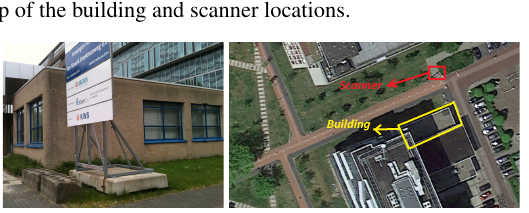
Figure 1: Left; the building chosen for our first showcase. Right; Google earth view indicating the location of the building of inter- est and the TLS scanner position.